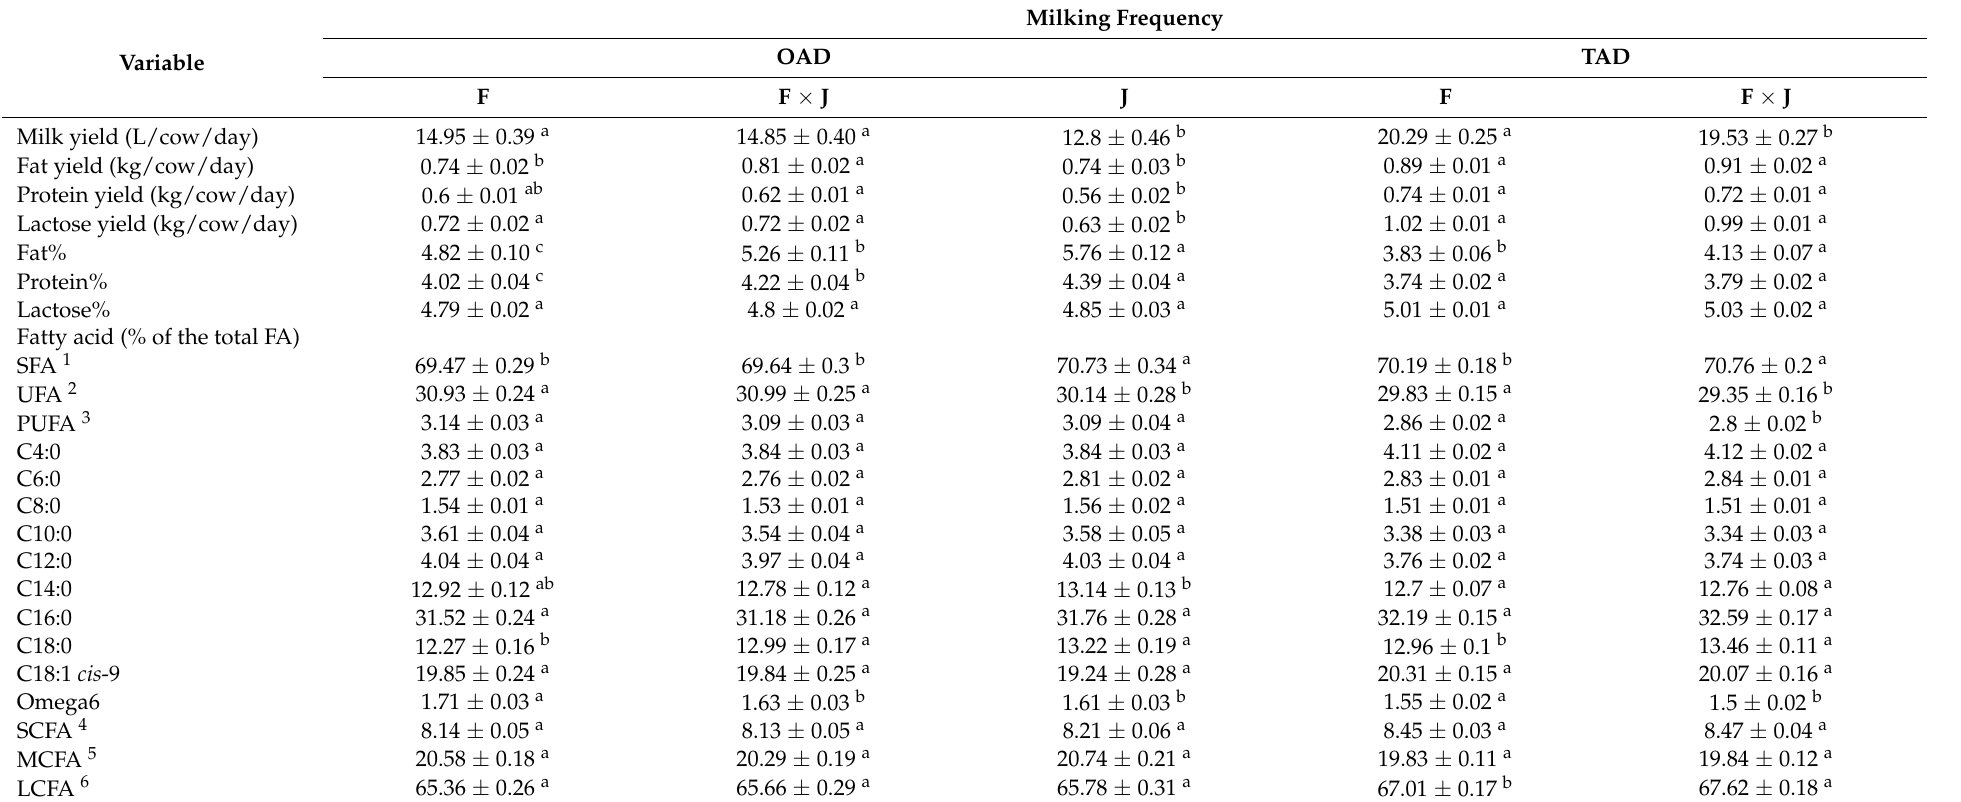
Table 3. Least squares means and standard errors for the production traits, milk composition and fatty acid composition of milk from Holstein-Friesian (F), Holstein-Friesian × Jersey (F × J) and Jersey (J) cows milked once-a-day (OAD) and twice-a-day (TAD) in the 2020–2021 production